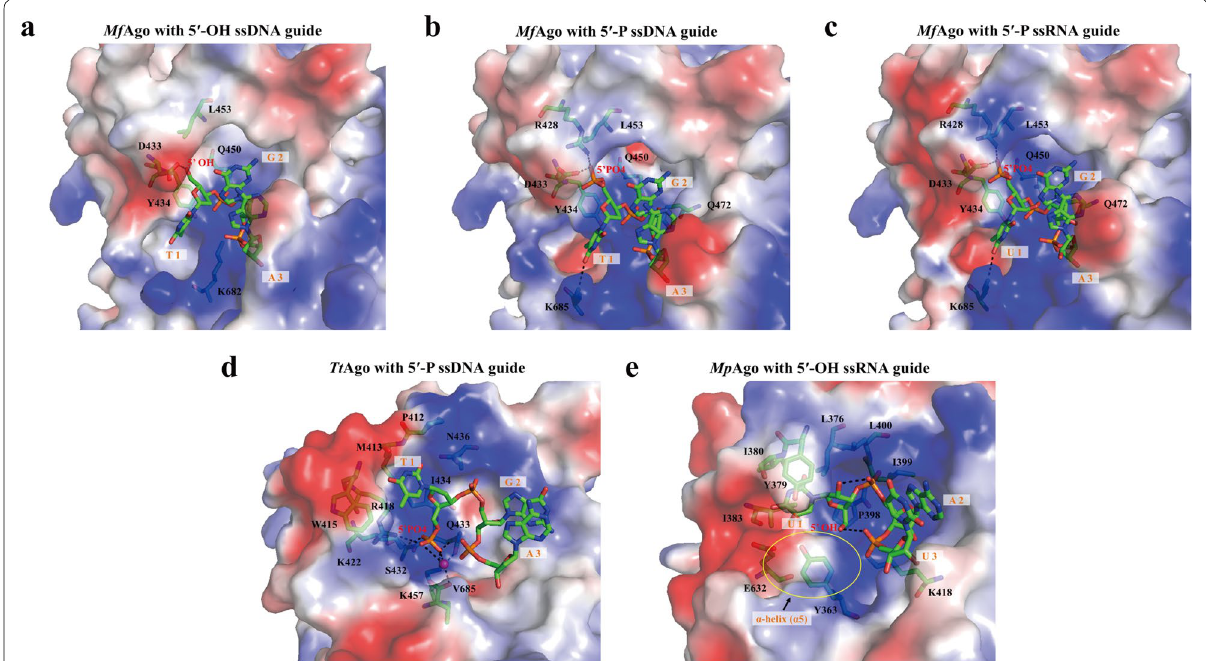
Fig. 8 The structural analysis and electrostatic heat map (red pocket of Mf Ago for varied guides. The predicted binding pocket of Mf Ago with a 5 ′ -OH ssDNA guide ( a ), 5 ′ -P ssDNA guide ( b ), and 5 ′ -P ssRNA guide ( c ). d The binding pocket of Tt Ago with a 5 ′ -P ssDNA guide. e The binding pocket of Mp Ago with a 5 ′ -OH ssRNA